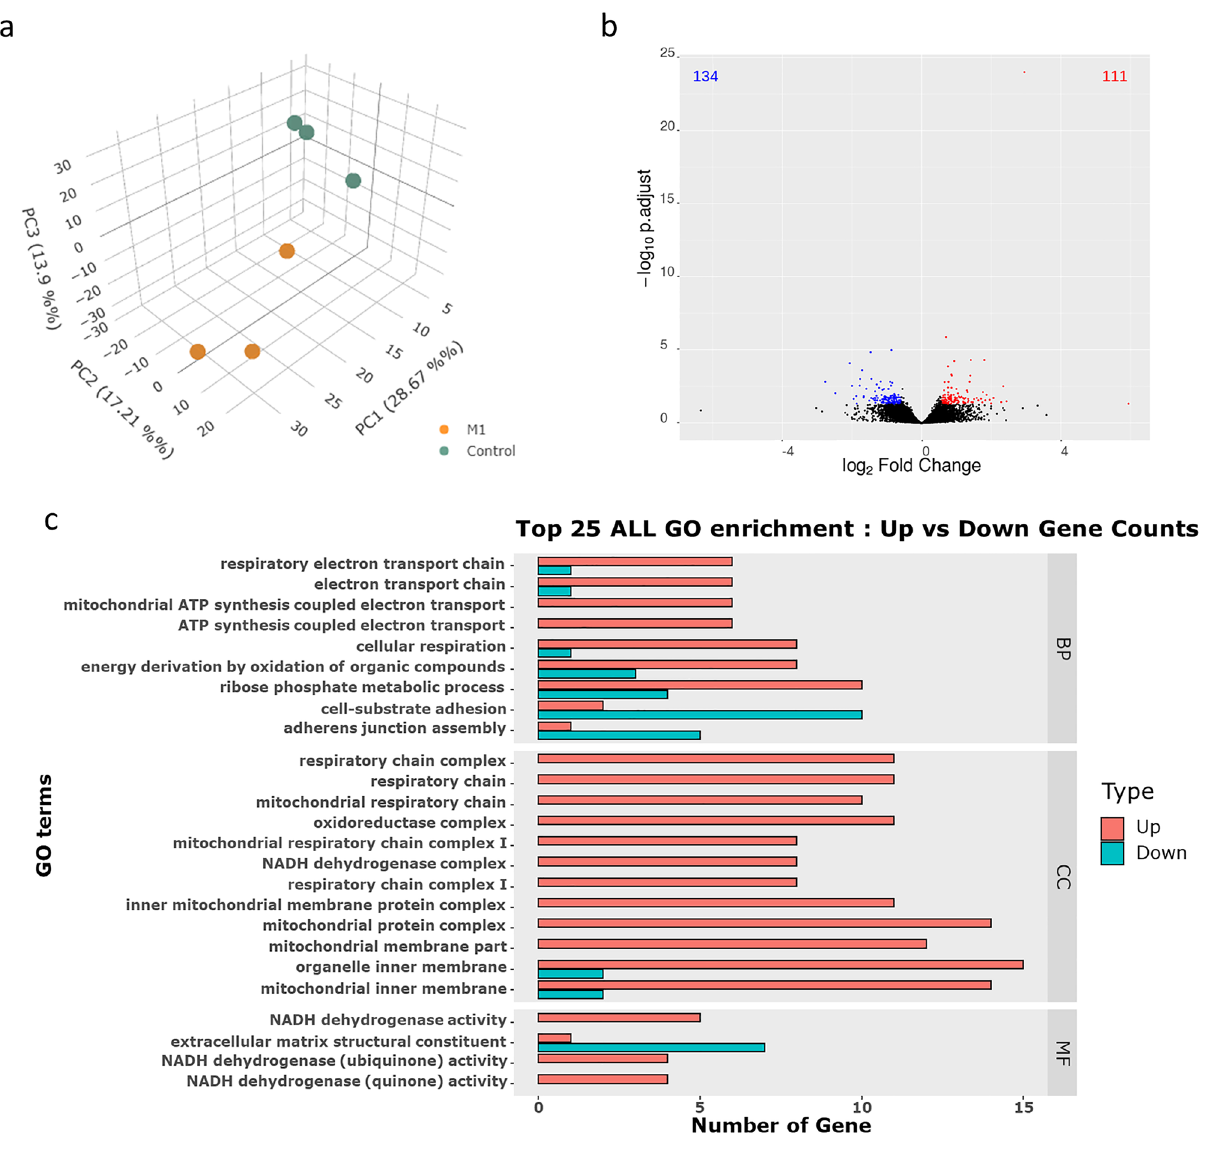
Figure 4. M1 injection promoted the expression of the genes of mitochondrial respiratory chain complexes and suppressed the genes associated with cell adhesion in the ovary. After M1 or control treatments on proestrus, the ovaries were collected in the evening (20:00) for transcriptome analysis (n = 3). The 3D principal component analysis revealed the similarity among samples and groups ( a ). The volcano plot showed the distribution of differentially expressed genes with P- adjust values and fold changes ( b ). The genes were filtered and GO analysis was performed, top 25 GO terms ( P < 0.05) were shown in the compare barplot ( c found to be disrupted in the mouse during ten days of exposure to M1 and recovered after the treatment stop, suggesting the M1 could have a mild and reversible impact on the female reproductive system of the mouse. At the beginning of M1 treatments, the confirmed proestrus phase was changed to the diestrous phase 3 h after the first M1 injection, suggesting an acute response of the reproductive system to M1 exposure. The steroid hormones like estrogen and progesterone could regulate vaginal epithelial cell growth, leukocyte infiltration, and mucus secretions 7,22–24 . In rodents, the stage with the highest serum progesterone level has been reported in literature to be inconsistent, varying from late-proestrus, estrus, and diestrous 25–27 . This could be due to the variation and dramatic changes in reproductive events in rodents. In recent studies, the lowest progesterone concentration could be found in diestrus, while the elevation of progesterone happened in proestrus or estrus stage 25,26 . LH surge is also expected in the late proestrus, although the exact time window is hard to observe 28 . In our study, the progesterone was elevated in the proestrus evening, which is consistent with previous reports on rats 26 . The M1 injection resulted in an ambiguous reduction in serum progesterone, which could reflect the complexity of physiological events on the day of rodent proestrus. The LH showed a similar level between the proestrus morning and evening in the control group, suggesting the LH level could reflect the basal secretion level through our sampling schedule 8 . The LH was lower in the M1 group. Such changes could take part in the